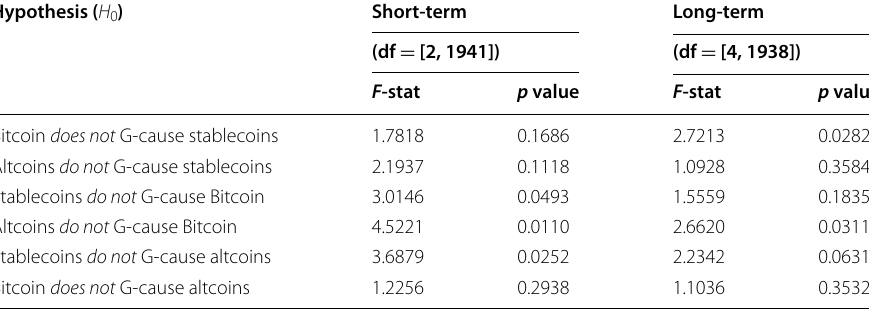
Table 4 Granger causality on market